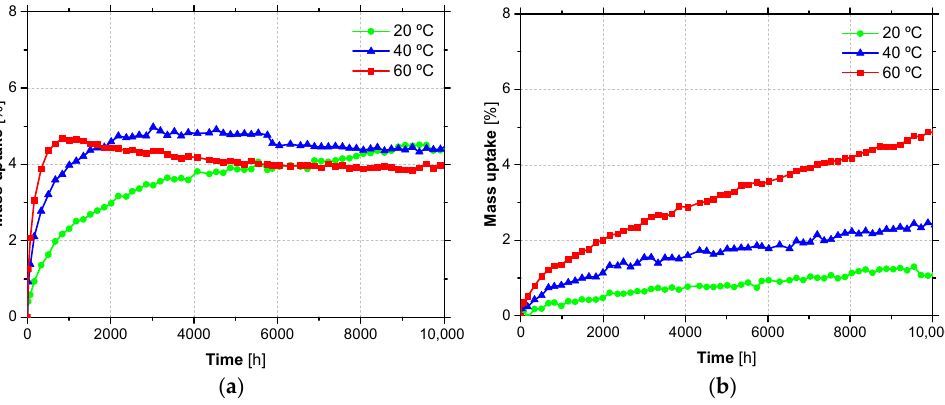
Figure 8. DMA experimental curves of unaged adhesives ( a ) ADH1 and ( b ) ADH2—in two con- secutive temperature runs.